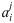
An example subgraph of the human disease-gene association network.The bipartite network has two sets of vertices, i.e., genes and diseases, represented by rectangle and gray ellipses respectively. An edge connects a disease and a gene if there is a known association between them. The weight of an edge reflects the strength of the DGA aij between disease i and gene j.